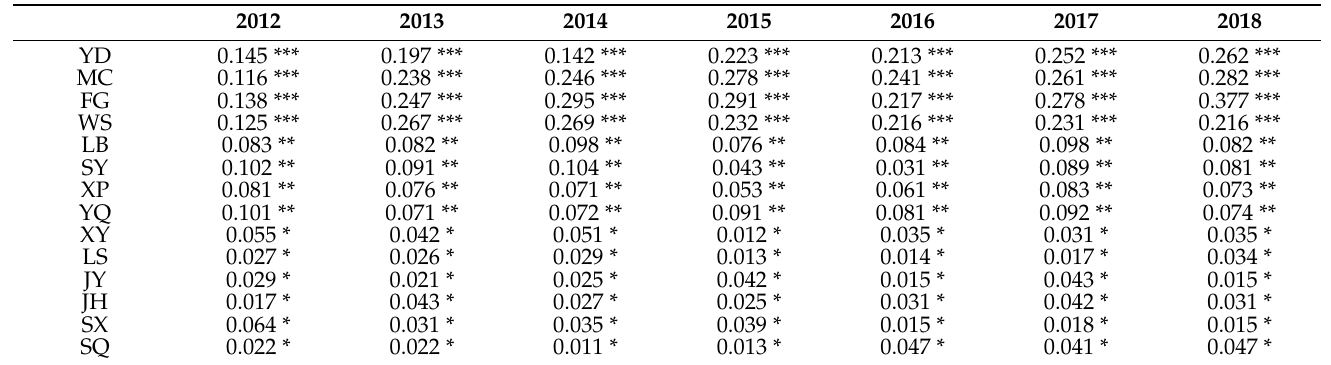
Table 1. Point density of environmental factors in 14 counties of the HRB.